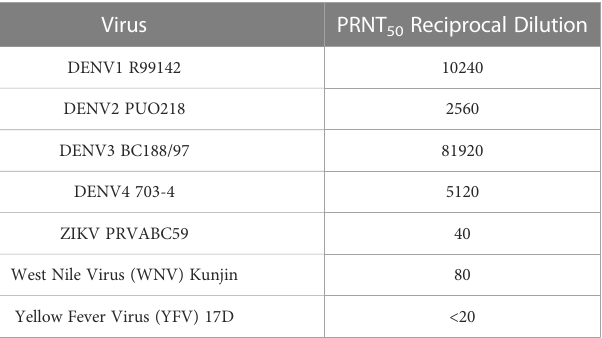
TABLE 2 Serological characterization of the anti-dengue virus (DENV)